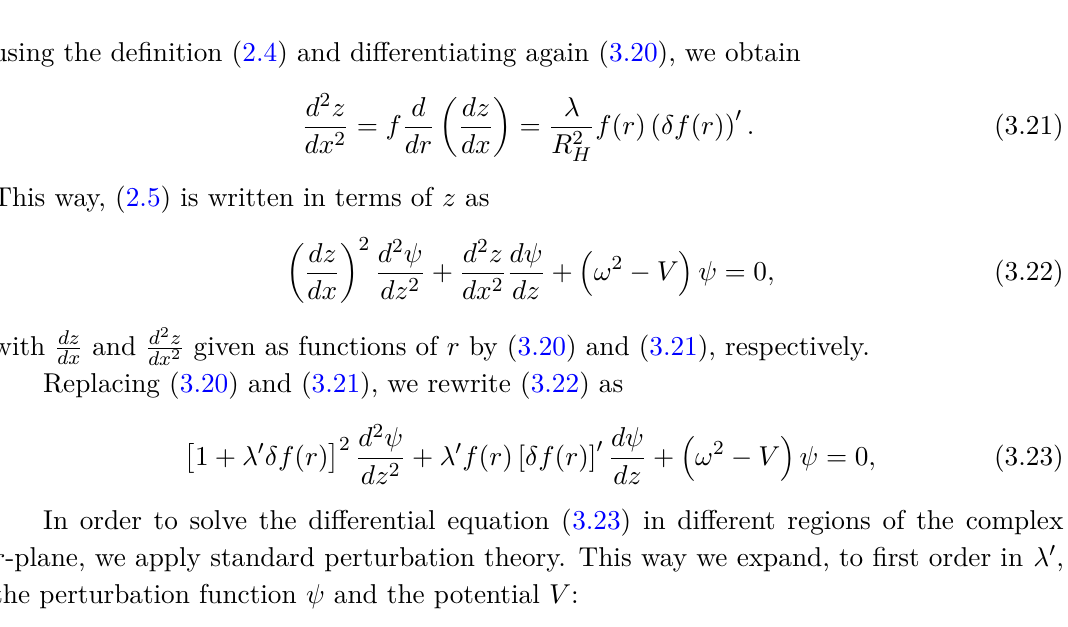
Figure 1 . Numerical plot of the Stokes lines topology for different dimensions. The horizontal axis stands for Re( r/R ) and the vertical axis stands for Im( r/R H physical horizon R and of the fictitious horizons by red H